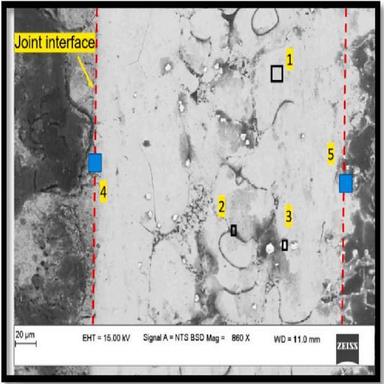
SEM image of joint region.